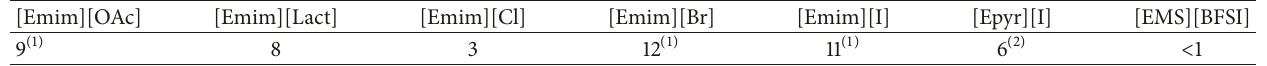
Table 1: Solubility of chitin in ionic liquids (% w/w) at 105 ∘ C.